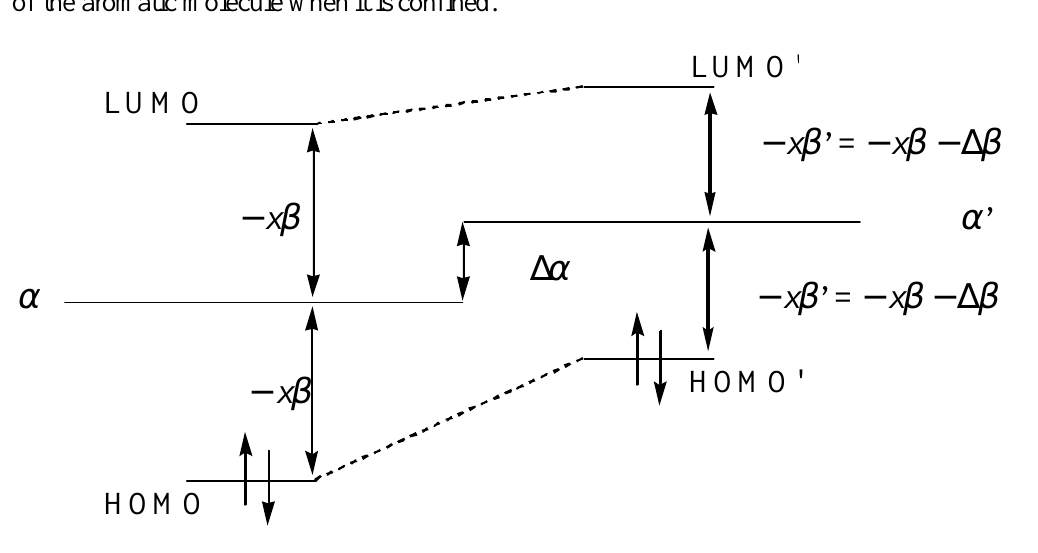
Figure 7: Qualitative description of the frontier orbital energy spectrum for the conjugated